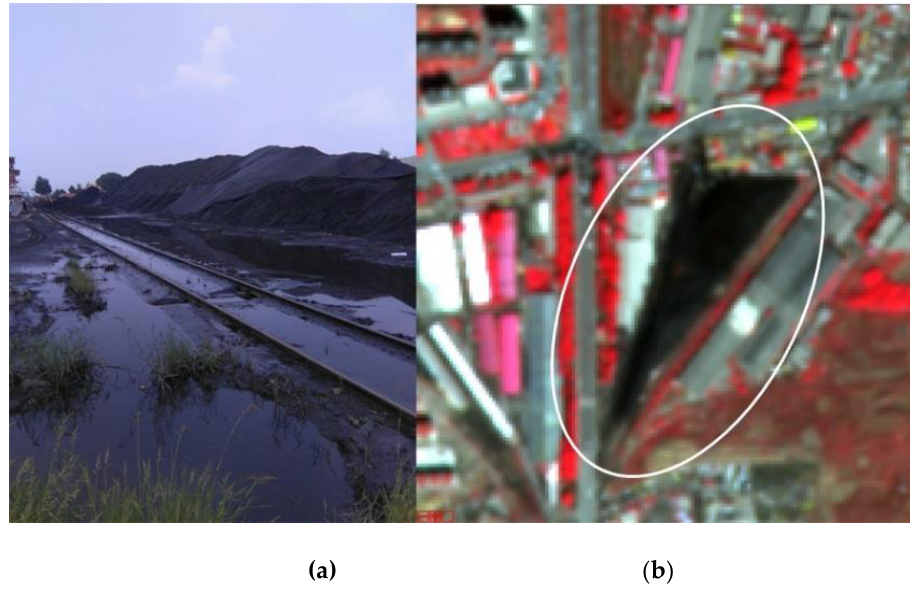
Figure 6. ( a ) a coal ash site and ( b ) its appearance in the image. Sensors. 2019 , 11 , x FOR PEER REVIEW